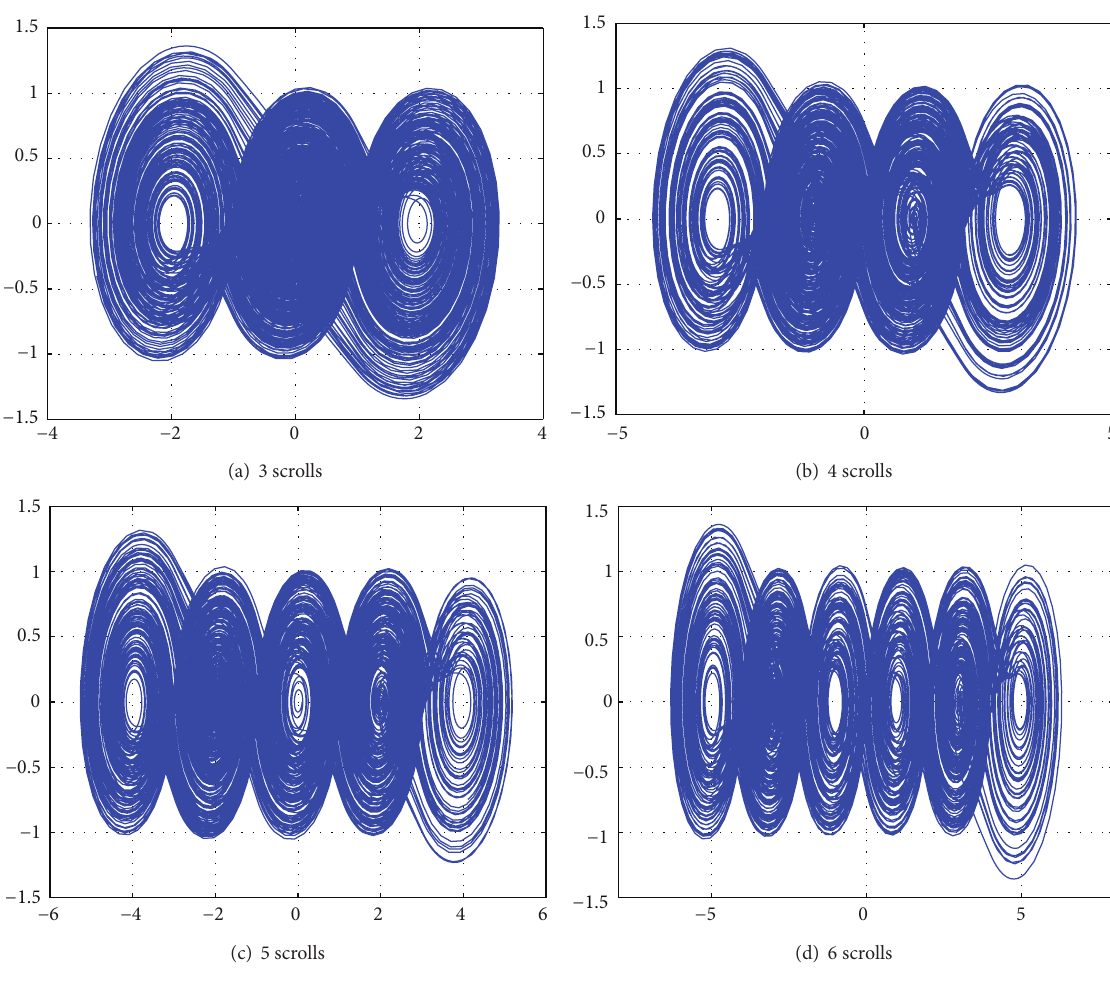
Figure 2: Phase space portraits for generating from 3 to 6 scrolls using